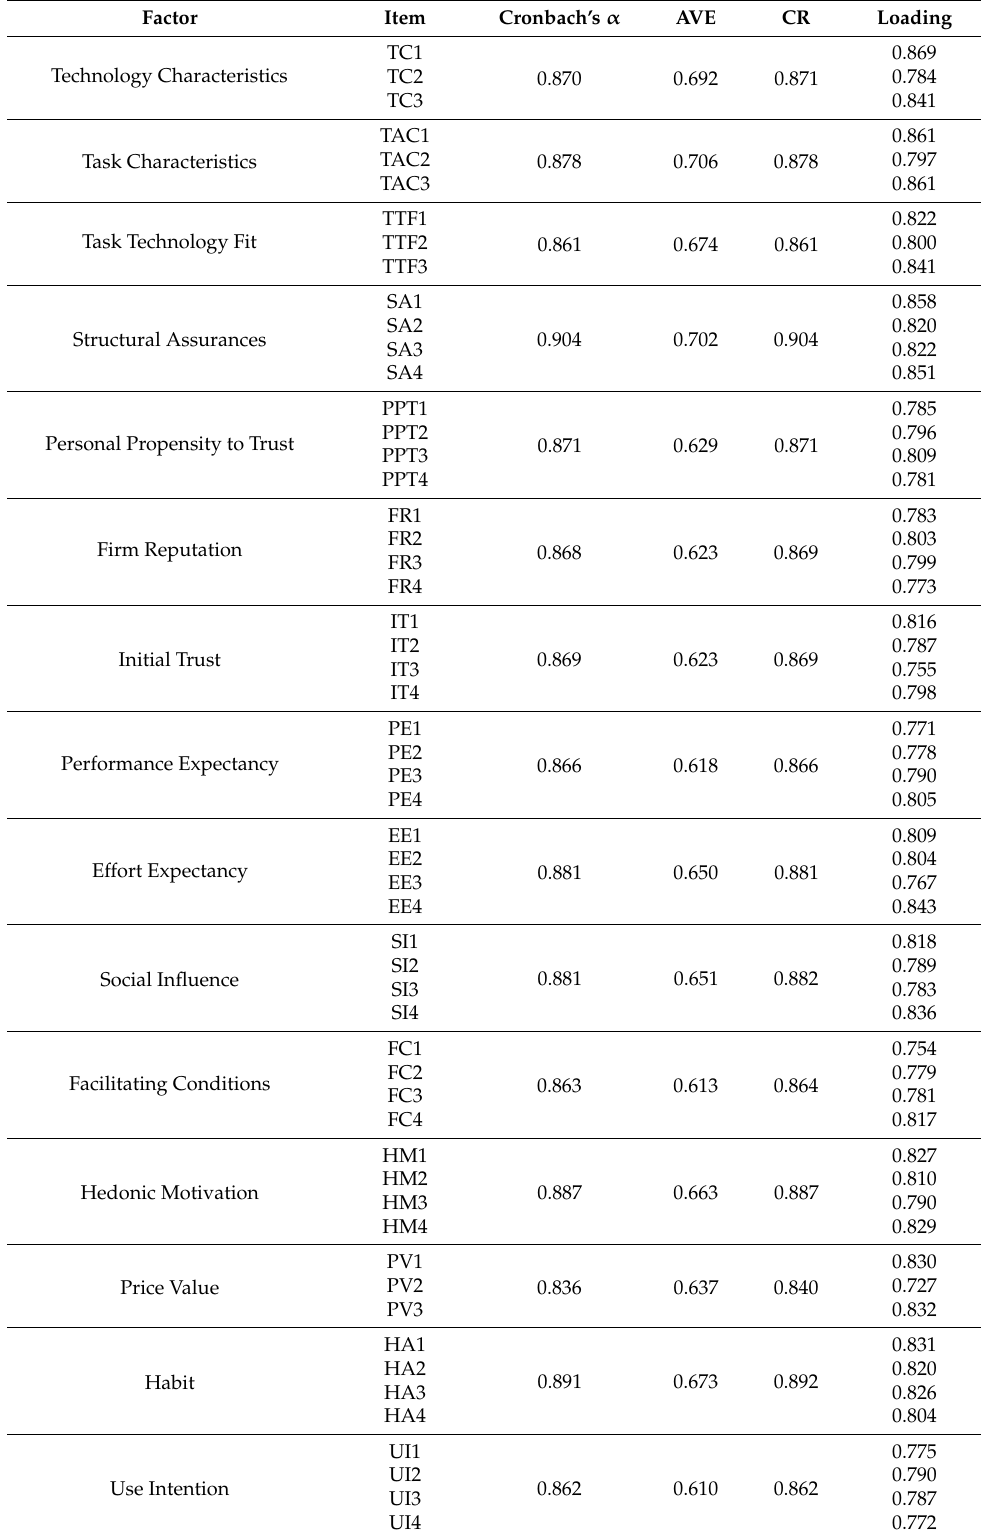
Table 3. Quality criteria (AVE, CR, Cronbach’s α ) and loadings.